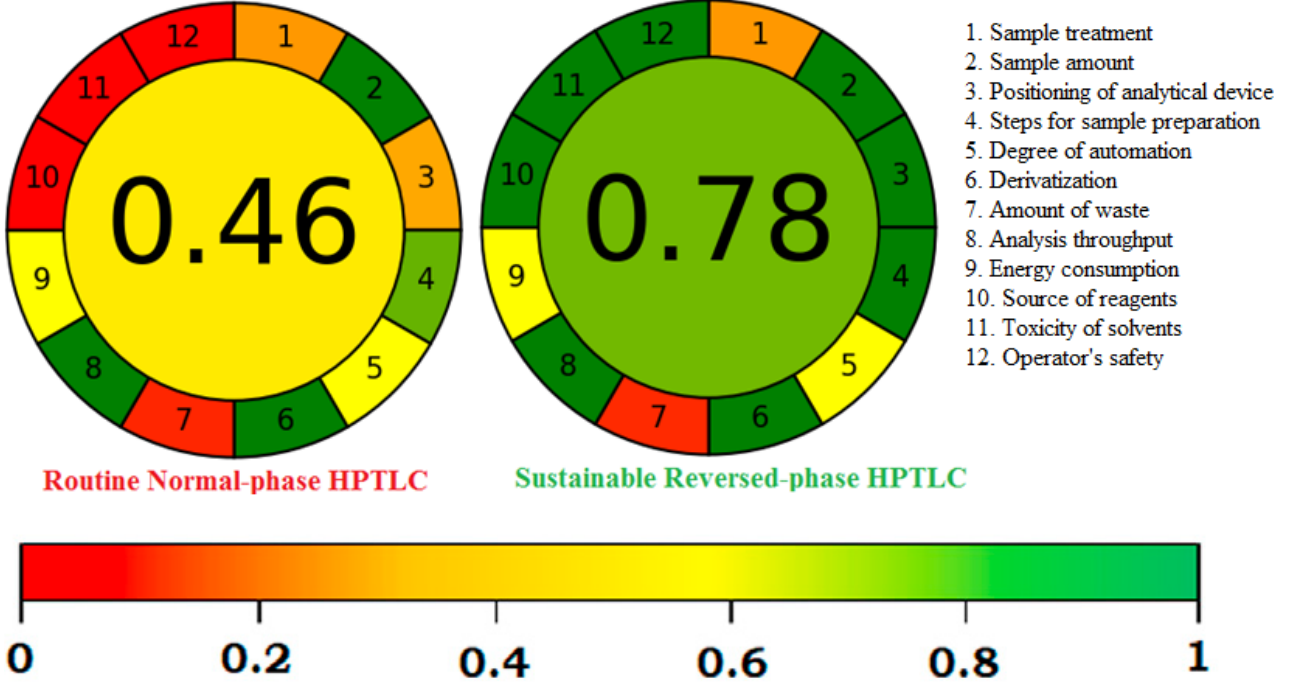
Figure 4. Representative pictograms for analytical GREEnness (AGREE) scores for the routine normal-phase HPTLC and sustainable reversed-phase HPTLC techniques obtained using the AGREE approach.